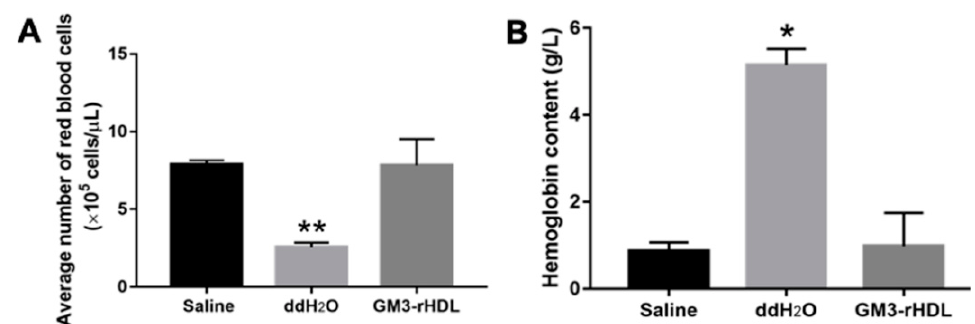
Figure 4. Biocompatibility of GM3-rHDL nanoparticles in ApoE − / − mouse blood. ( A ) Effects of saline (0.9% NaCl), double distilled water (ddH 2 O), and GM3 H -rHDL nanoparticles on the number of red blood cells in the pellet after 48 h of deposition. ( B ) Effects of saline, ddH 2 O, and GM3 H -rHDL nanoparticles on the content of hemoglobin in suspension after 48 h of deposition. * p < 0.05, ** p < 0.01 ( n = 3) compared with the control (the saline group).